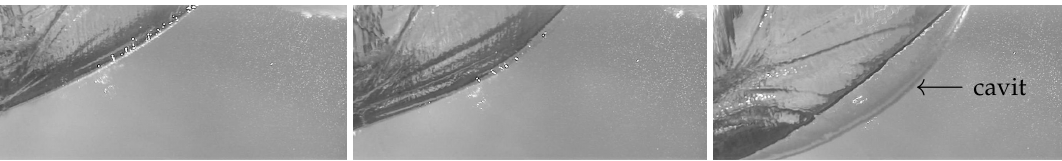
cavit. ←− 4.3 m/s at 40, ≈